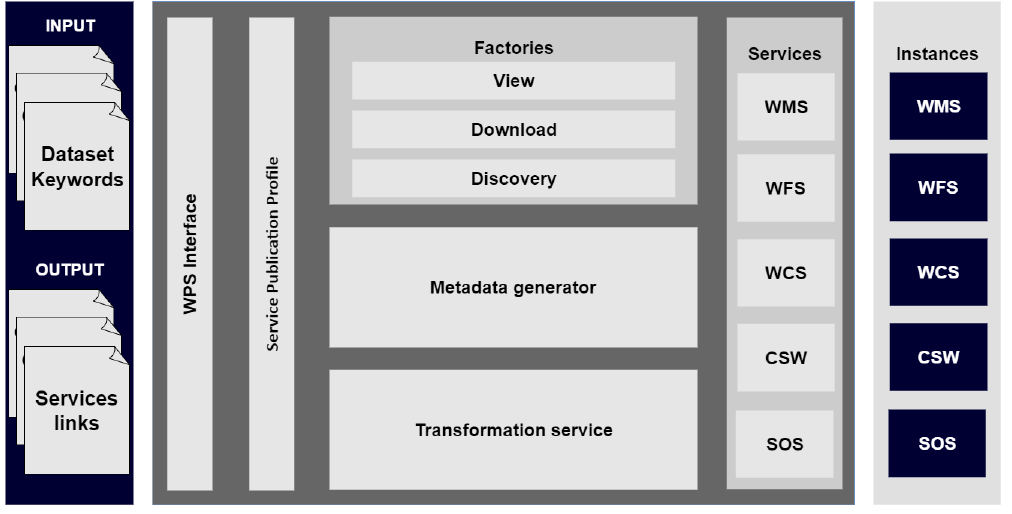
Figure 3. Different components of the Global Earth Observation System of Systems (GEOSS) Service Factory